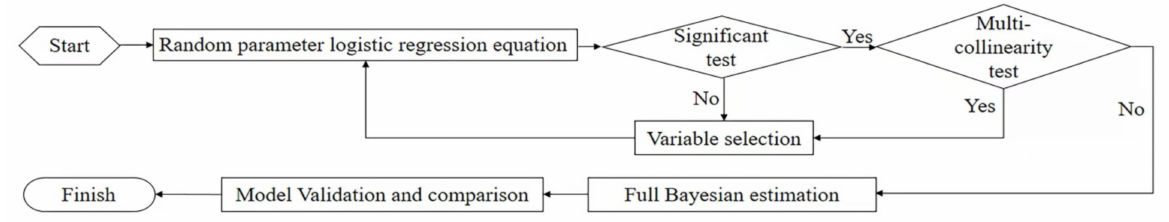
Figure 3. Diagram of Bayesian random parameter logit